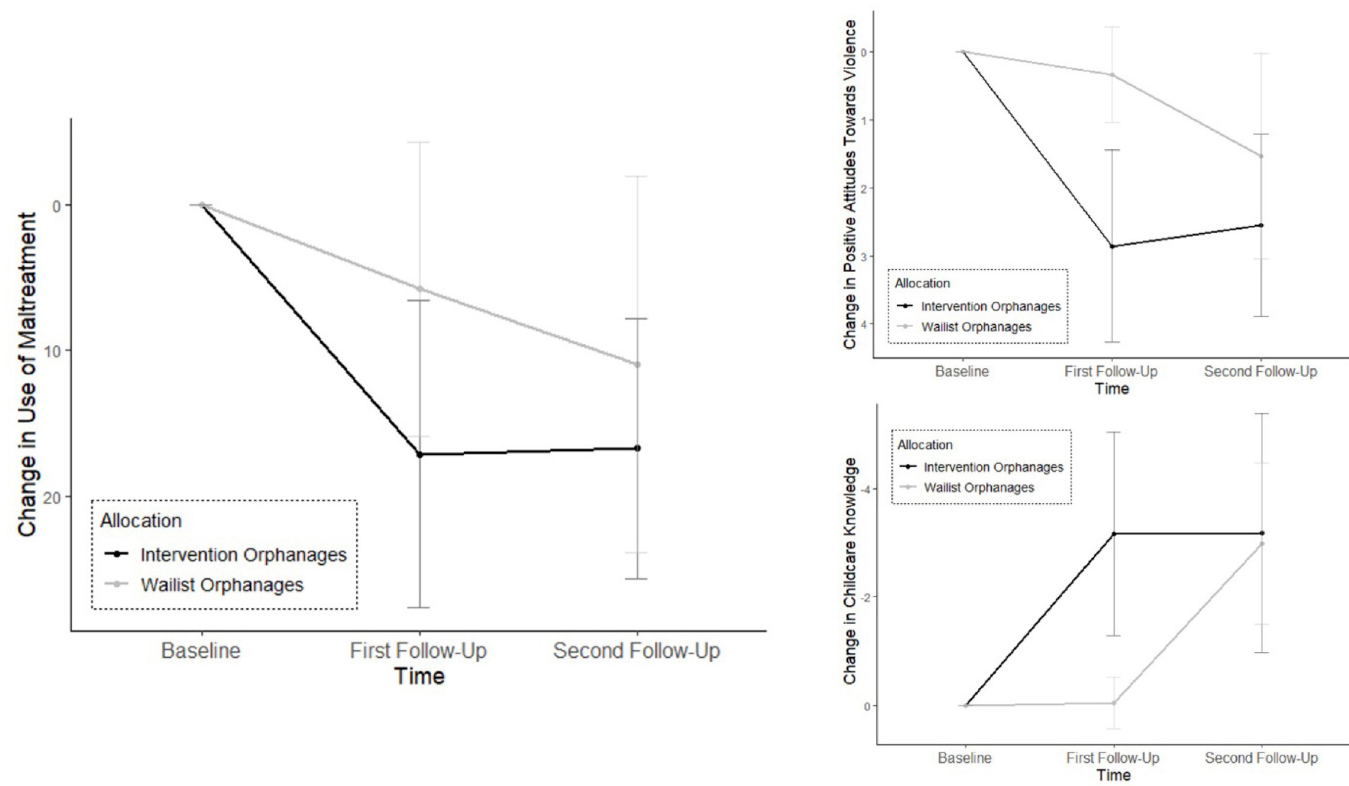
Fig 2. Change in primary outcomes over time separated by intervention and waitlist orphanages. The graphic displays the trimmed and transformed means ( M standard deviations ( SD ab ) for use of maltreatment, positive attitudes towards violence and childcare knowledge at all three time points. The values for first and second follow-up represent the respective difference to the baseline value. A positive difference indicates a decrease while a negative difference stands for an increase of the respective outcome measure over time. Note that the y-axis was mirrored for interpretative ease. Across all primary outcome measures, a clear picture emerges while the values of the intervention orphanages remain stable between first and second follow-up, the waitlist orphanages show decreases in use of maltreatment and positive attitudes towards violence as well as an increase in childcare knowledge after their participation in ICC-C